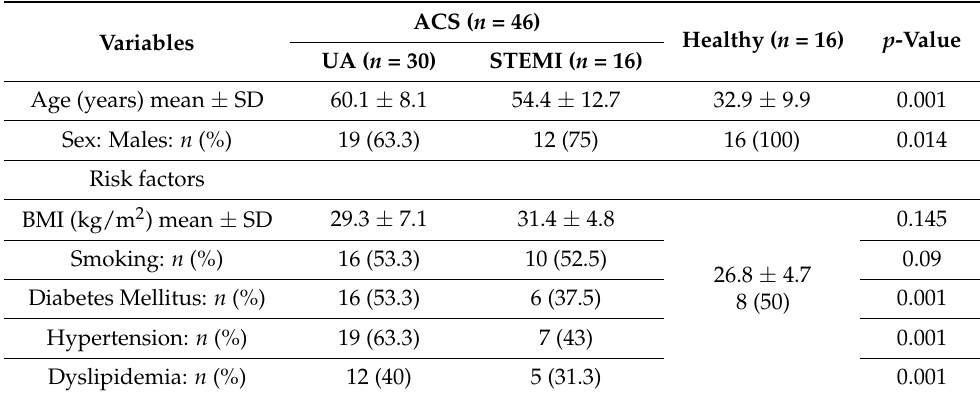
Table 1. Clinical Characteristics of Patient